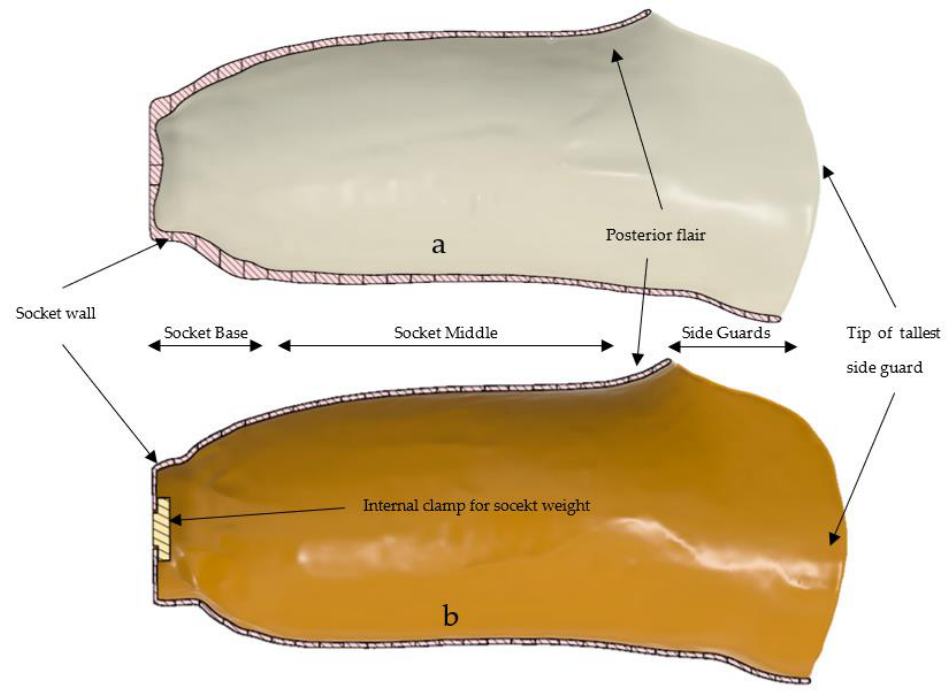
Figure 6. Cross sectional analysis of the socket, including the visual reference points: ( a ) cross sec- tional view of the digital socket scan; ( b ) the digital reference model that was 3D printed. From the six sections of each slice the horizontal socket wall thickness was extracted. The average thickness for each slice is shown in Figure 7. Similar to the trend seen in re- gard to the slice volume, the average wall thickness at the base of the socket is significantly higher in the scanned mesh. The scan wall thickness also increases nearer the brim of the socket, reducing the accuracy in this region.